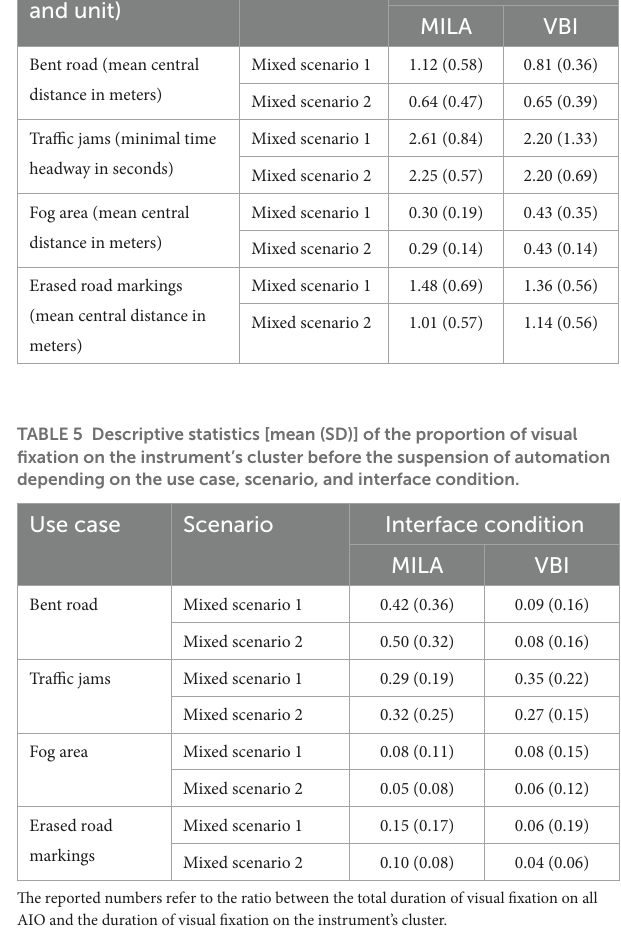
TABLE 4 Descriptive statistics [mean (SD)] of the driving performance measures depending on the use case, scenario, and interface condition. Use case (metric and unit)